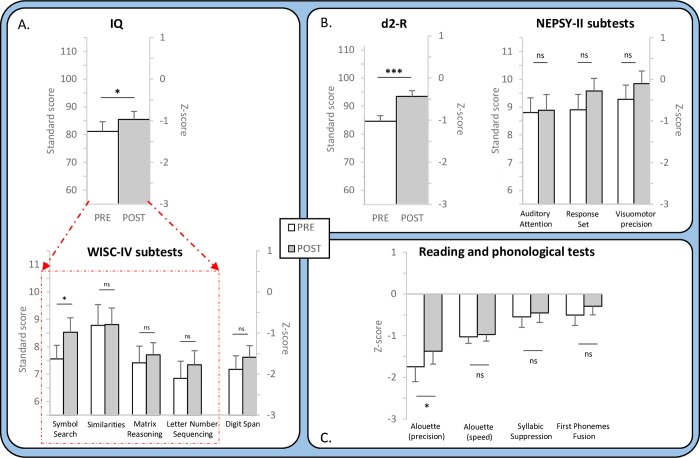
Pre- and post-training results for all tests.A. Results for total Intelligence Quotient (IQ) score, for the four subtests of the reduced version of WISC-IV and for the digit span test are compared in the pre- and post-music training sessions. B. Results at the d2-R and NEPSY-II subtests are compared in the pre- and post-music training sessions. For both A and B, standard scores are indicated on the left ordinate and z-scores on the right ordinate. C. Results at the Alouette reading test and at the phonological tests are compared in the pre- and post-music training sessions. Z-scores are indicated on the left ordinate. Significant pre vs post differences with *: p < .05; ***: p < .001; ns: not significant. Error bars are standard errors of mean (SEM).